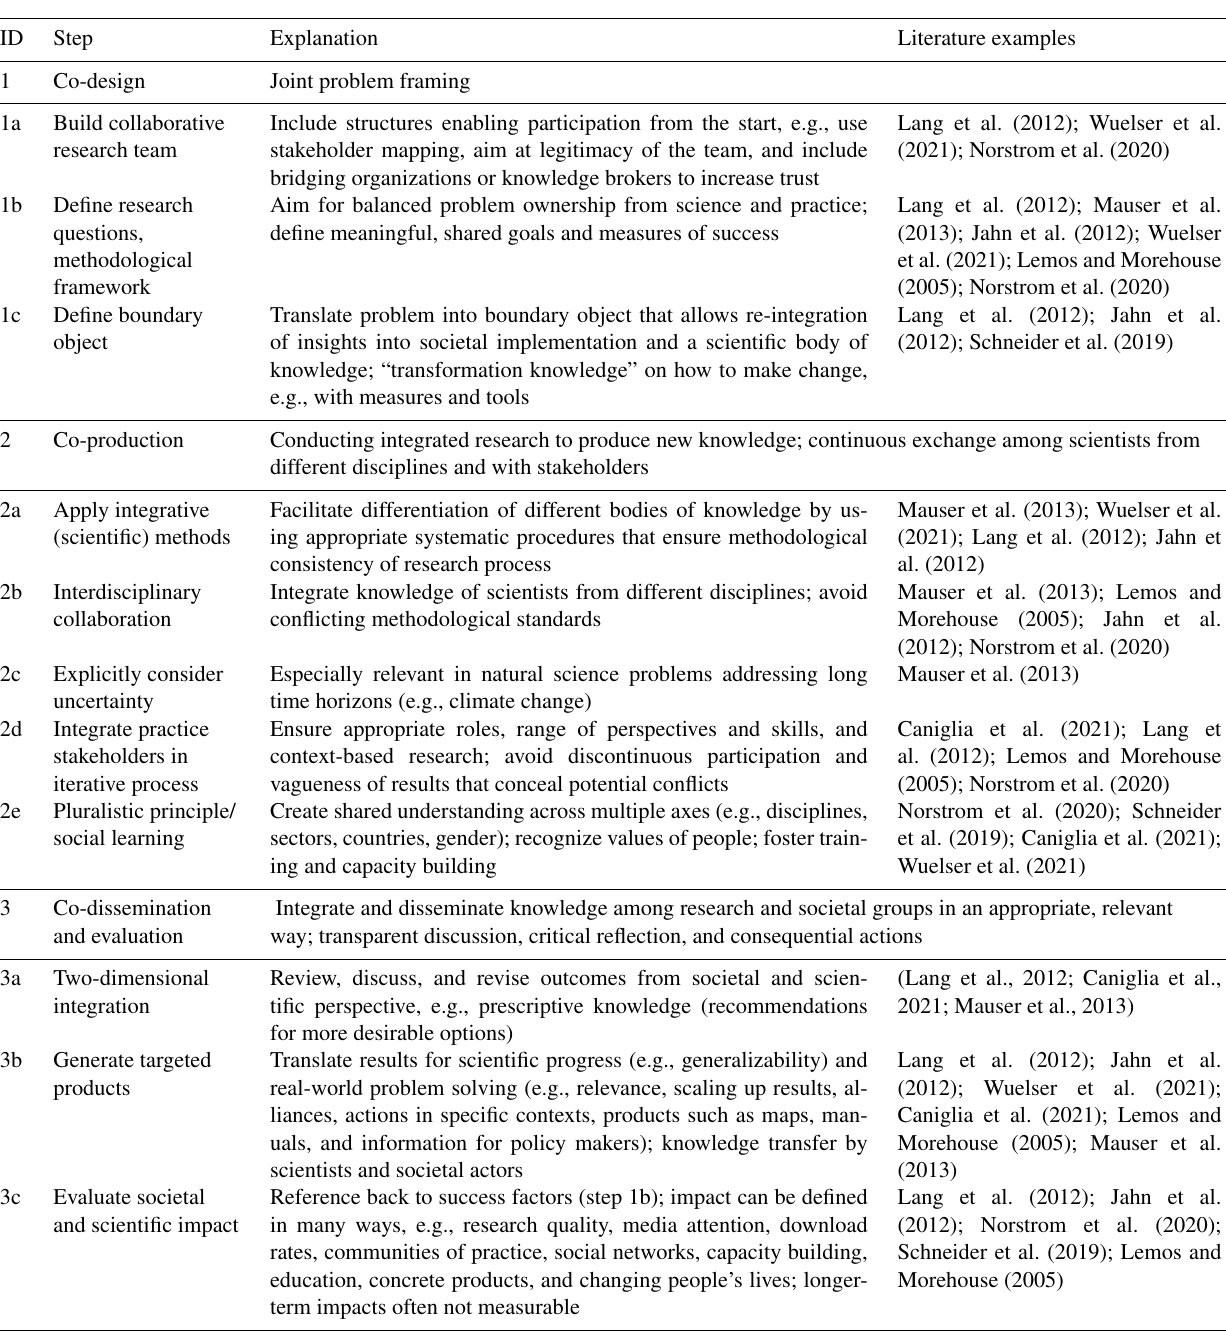
Table 1. Conceptual framework for transdisciplinary research based on the literature: (1) co-design, (2) co-production, and (3) co- dissemination of knowledge (terminology from Mauser et al., 2013) used to assess the MCDA process in the FANFAR